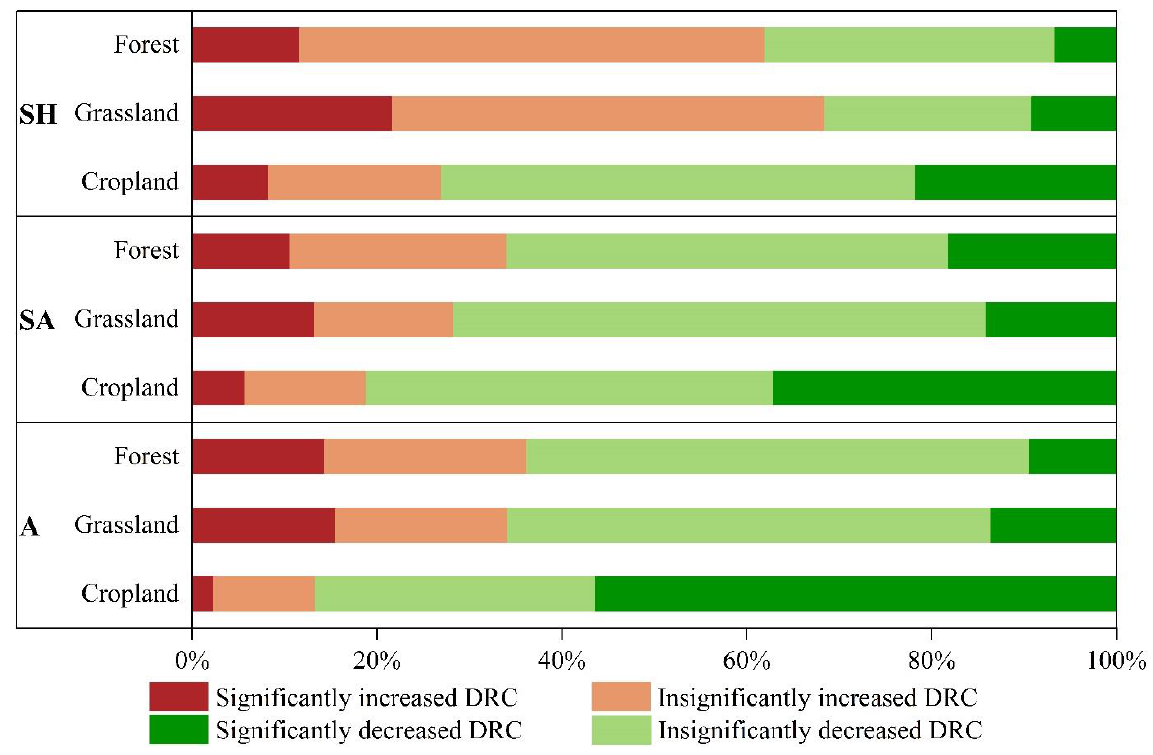
Figure 6. Percentage change of DRC (Drought Resistance Coefficient) across climate zones and vegetation biotypes. Semi-humid regions (SH), Semi-arid regions (SA), and Arid regions (A).